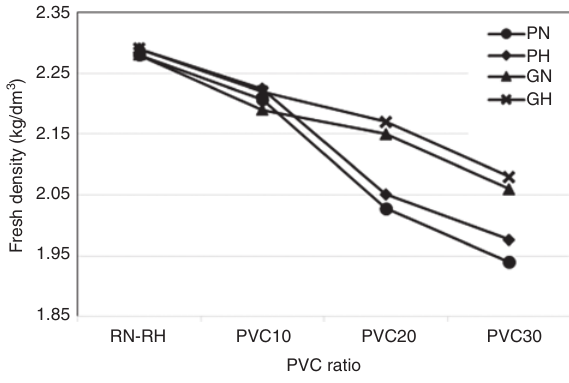
Figure 6 Fresh density tests of polyvinyl chloride-containing concretes.